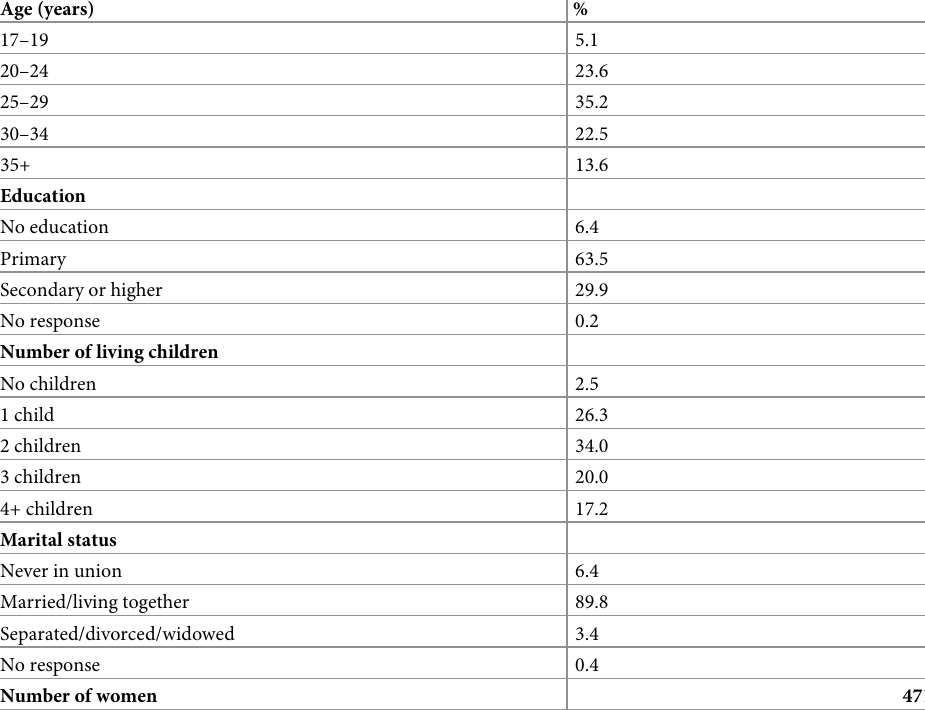
Table 1. Background characteristics of FP clients percent distribution of interviewed women by age group, educa- tion, number of living children, and marital status, Tanzania 2018.